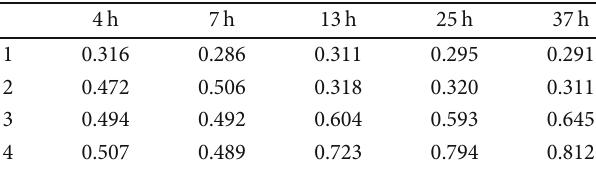
Table 4: After administration Ach level in all